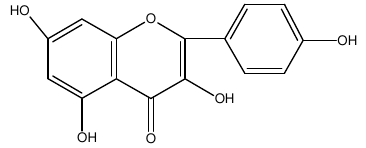
Figure 2. The structure formula of quercetin 7- o -galactoside